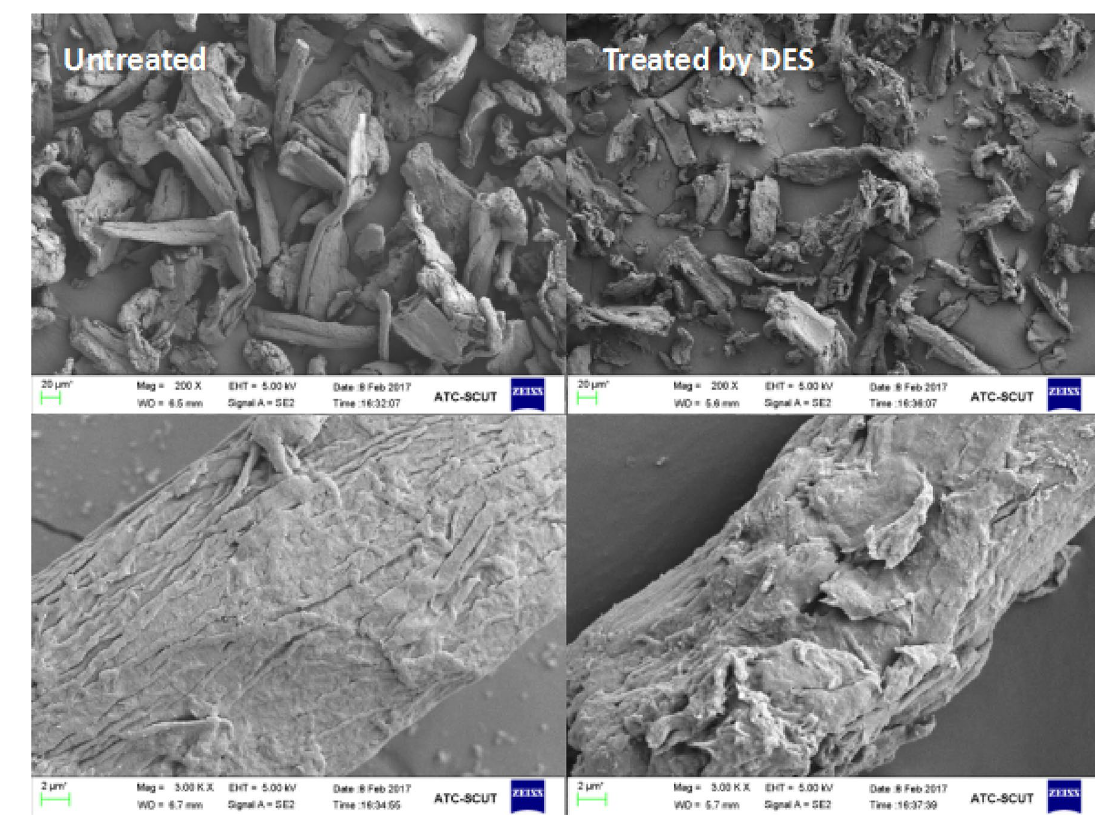
Fig. 10 SEM analysis of the microcrystalline cellulose before and after